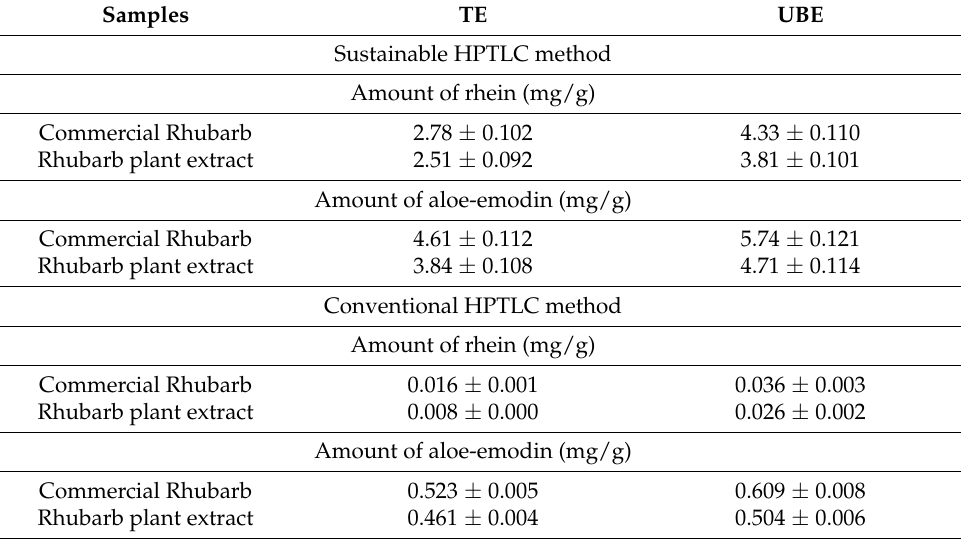
Table 6. Application of sustainable and conventional analytical methods in simultaneous analysis of rhein and aloe-emodin in traditional extract (TE) and ultrasound-based extract (UBE) of commercial Rhubarb and Rhubarb plant extract (mean ± SD; n =